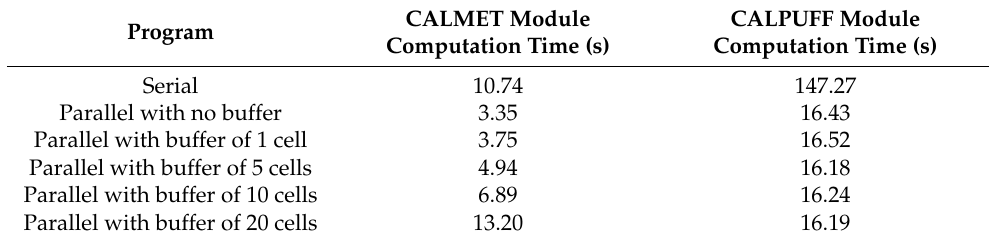
Table 2. The computation times of the serial and parallel programs.